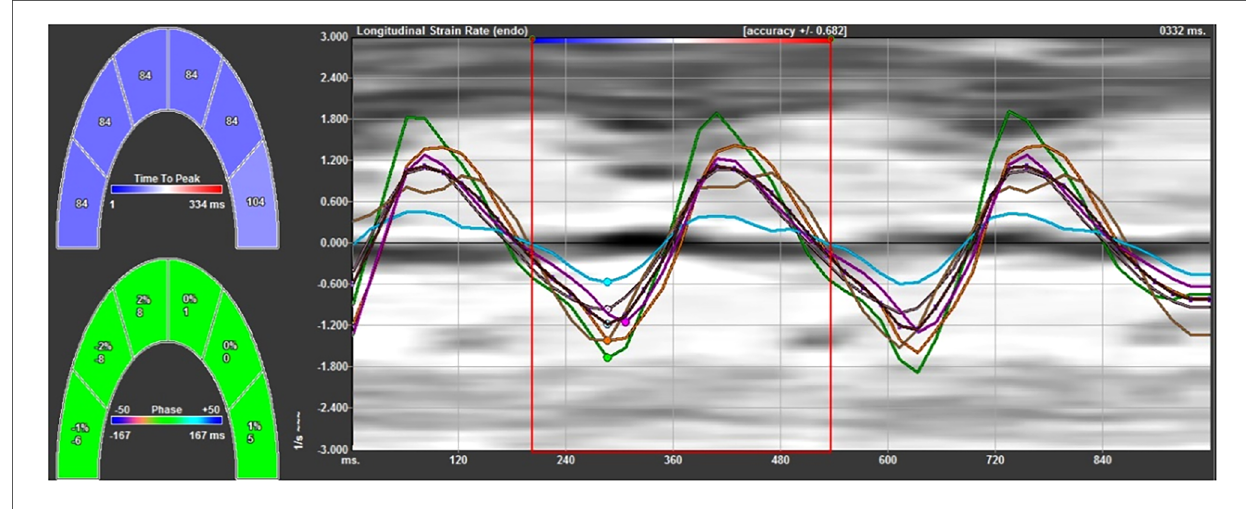
FIGURE 1 The strain rate curves of the left ventricular wall and left ventricular interventricular septum at each segment. The negative systolic strain rate indicates the longitudinal shortening of the myocardium, and the positive diastolic strain rate indicates the longitudinal elongation of the